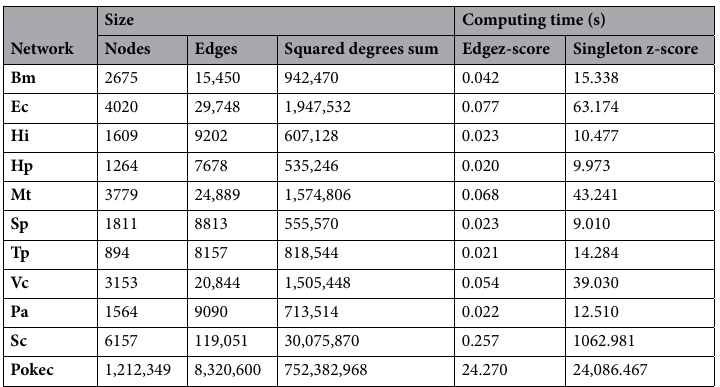
Table 4. Computing times for edge z -scores and singleton z -scores, on organisms and Pokec networks. For each network we report the number of nodes, the number of edges and the sum of squared degrees. The complexity of singleton z -scores computation strongly depends on the sum of squared degrees.